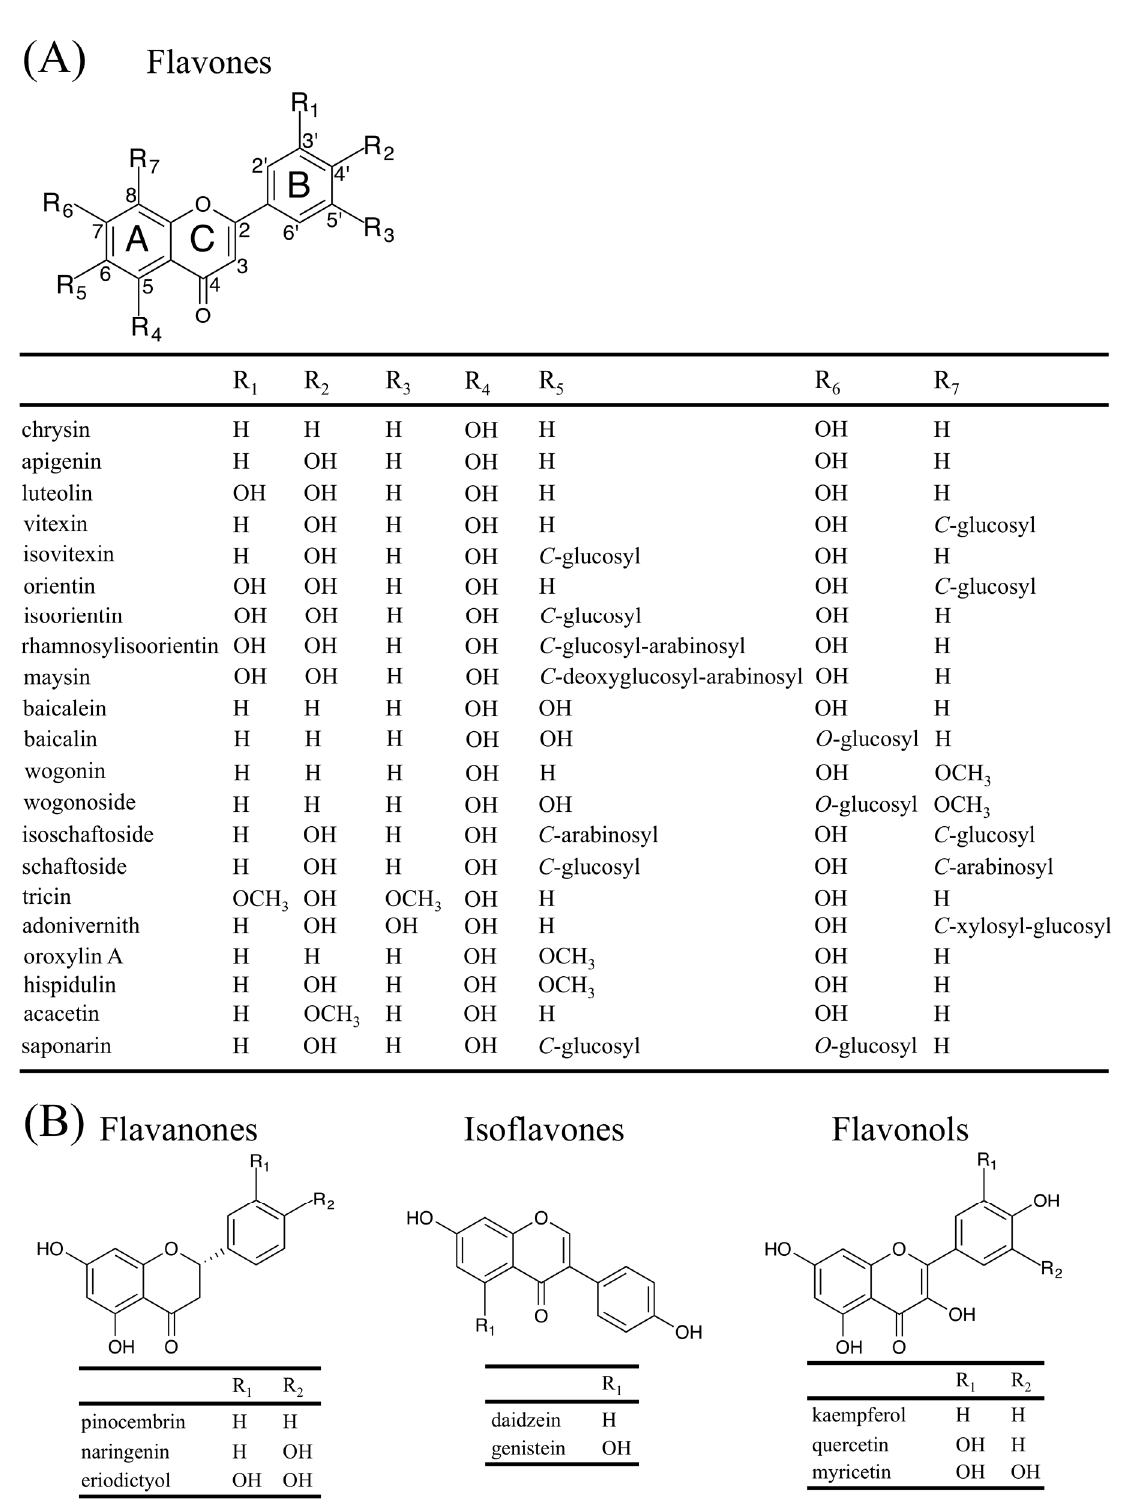
Figure 1. Structures of some important flavonoids discussed in this review: ( A ) flavones, including aglycones, C -/ O -glycosyl flavones, and O -methylated flavones; and ( B ) selected flavonoids mentioned in the text belonging to the flavanone, isoflavone, and flavonol groups.